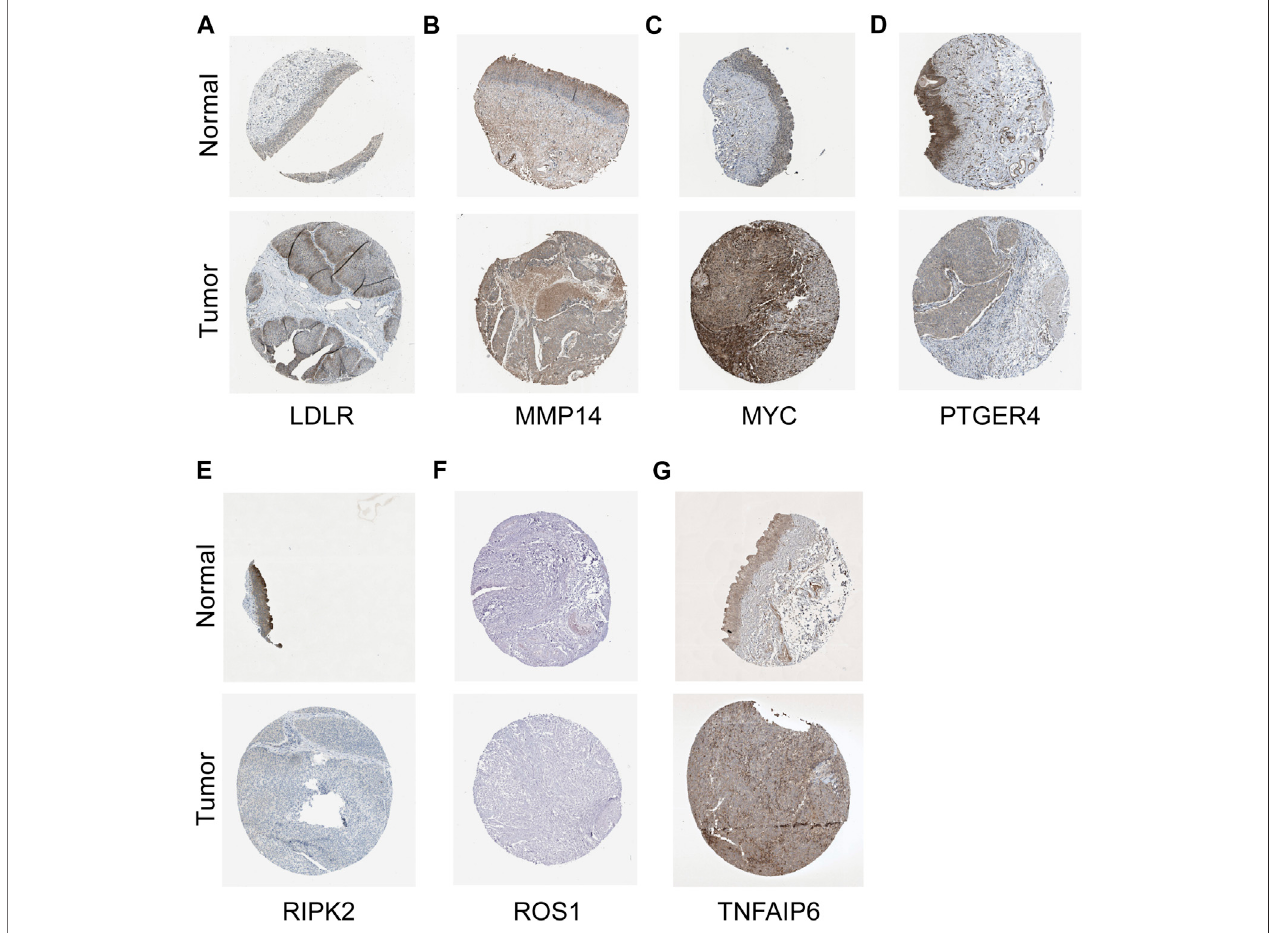
FIGURE 4 | IHC staining in validating expression levels of the signature genes. LDLR (A) , MMP14 (B) , MYC (C) , PTGER4 (D) , RIPK2 (E) , ROS1 (F) , and TNFAIP6 (G) in normal tissue and tumor tissues.